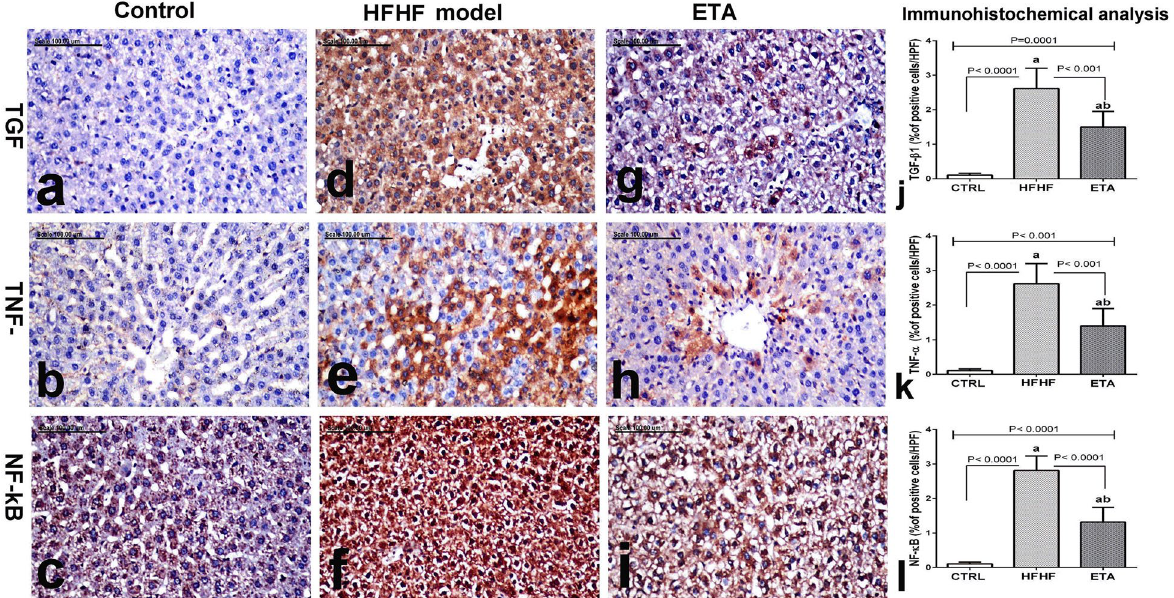
Figure 6. ETA attenuates NASH by downregulating the NF-κB/TNF-α/TGF-β1 signaling pathway activated by the HFHF model. Comparison data from the HFHF-fed rats and standard chow-fed rats (CTRL) are shown: immunohistochemically stained liver tissues of the normal control group ( a – c ) show no TGF-β1 ( a ) and TNF-α ( b ) expression and normal brown cytoplasmic staining of hepatocytes with no evidence of nuclear staining ( c ). The stained tissues of the HFHF group ( d – f ) show a significant increase of TGF-β1 ( d ) and TNF-α ( e ) positively stained cells and a significant increase of NF-κB positively stained cells with diffuse and extensive nuclear staining ( f ). The stained tissues of the ETA-treated group ( g – i ) show a few TGF-β1 ( g ) and TNF-α ( h ) positively stained cells along with sparse cells with brown nuclear staining ( i ). TGF-β1, TNF-α, and NF-κB immunohistochemical staining; scale bar = 100 µm. Data are presented as the mean ± SD values and are representative of a single independent experiment ( n = 6). Statistical analysis was performed using one-way ANOVA, followed by Tukey’s multiple comparison tests. a Significantly different from the normal control group. b Significantly different from the HFHF group. Differences were considered significant if the p-value was < 0.05. CTRL control, ETA etanercept, HFHF high-fat high-fructose diet, NF‑κB nuclear factor kappa beta, TGF‑β1 transforming growth factor beta, TNF‑α tumor necrosis